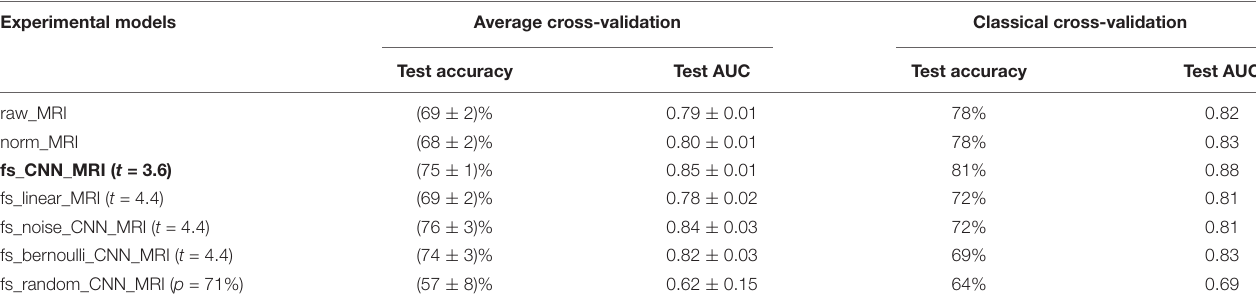
TABLE 1 | Test accuracy and AUC evaluated for each tested method with average cross-validation (the average between permutations) and classical cross-validation (the highest between permutations). Experimental